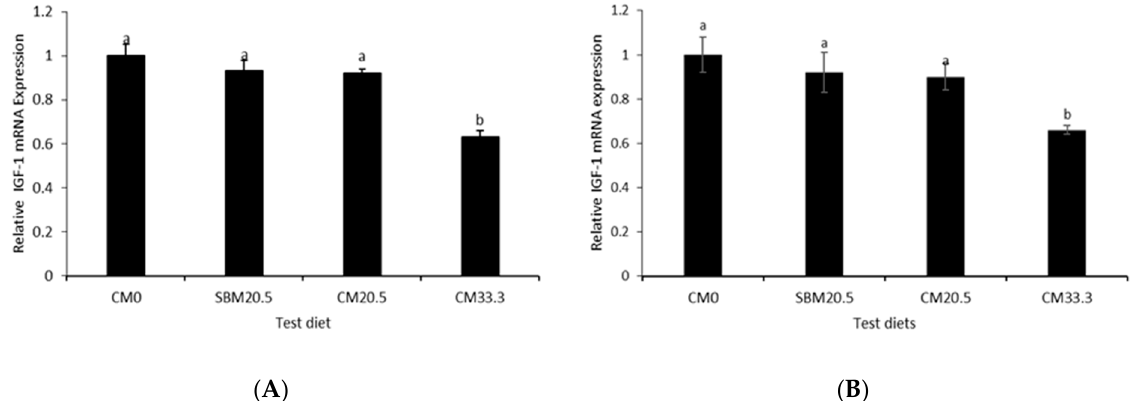
Figure 4. ( A , B ) qPCR analyses of relative expression of growth-related genes ( IGF-1 and IGF-2 ) in the liver of red seabream fed four different diets by replacing fish meal with camelina meal at 0% for reference diet (CM0), 20.5 g/kg with soybean mean (SBM20.5), 20.5 g/kg with camelina meal (CM20.5) and 33 g/kg camelina meal (CM33). Relative mRNA expressions results are presented in triplicated, n = 3 for all treatments. Letters indicate Turkey-Kramer post hoc test and confidence interval of 95% ( p > 0.05) interpreted as Values represent means of triplicate groups ± S.E.M., n = 3 means with different letters are significantly different ( p < 0.05); means with the same letters are not significantly different ( p > 0.05). S.E.M. represents the standard error of mean.